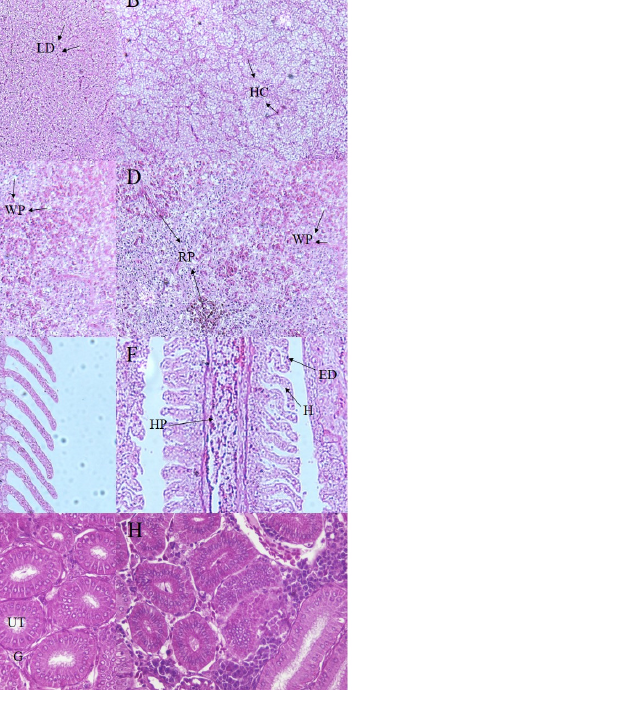
Figure 2. Histological changes in M. salmoides infected by the isolate GJL1. ( A ) histologic section of healthy liver; ( B ) histologic section of infected liver; (C) histologic section of healthy spleen; ( D ) histologic section of infected spleen; ( E ) histologic section of healthy gill; ( F ) histologic section of infected gill; ( G ) histologic section of healthy kidney; ( H ) histologic section of infected kidney. LD represents decreased lipid droplets; HC represents mild hepatic cell; CV represents swollen central vein. WP represents white pulp; RP represents red pulp. H represents hypertrophy; HP represents hyperplasia; ED represents epithelial cell detachment. G represents glomerulus; UT represents urine tubules. 3.5. Electron Microscopic Observation of the Isolate The micrographs of transmission electron microscopy revealed that the isolate GJL1 was rod-shaped with round-ends, approximately 1.1–1.9 μ m wide and 2.6–4.8 μ m long, which was motile by single polar flagella (Figure 3).